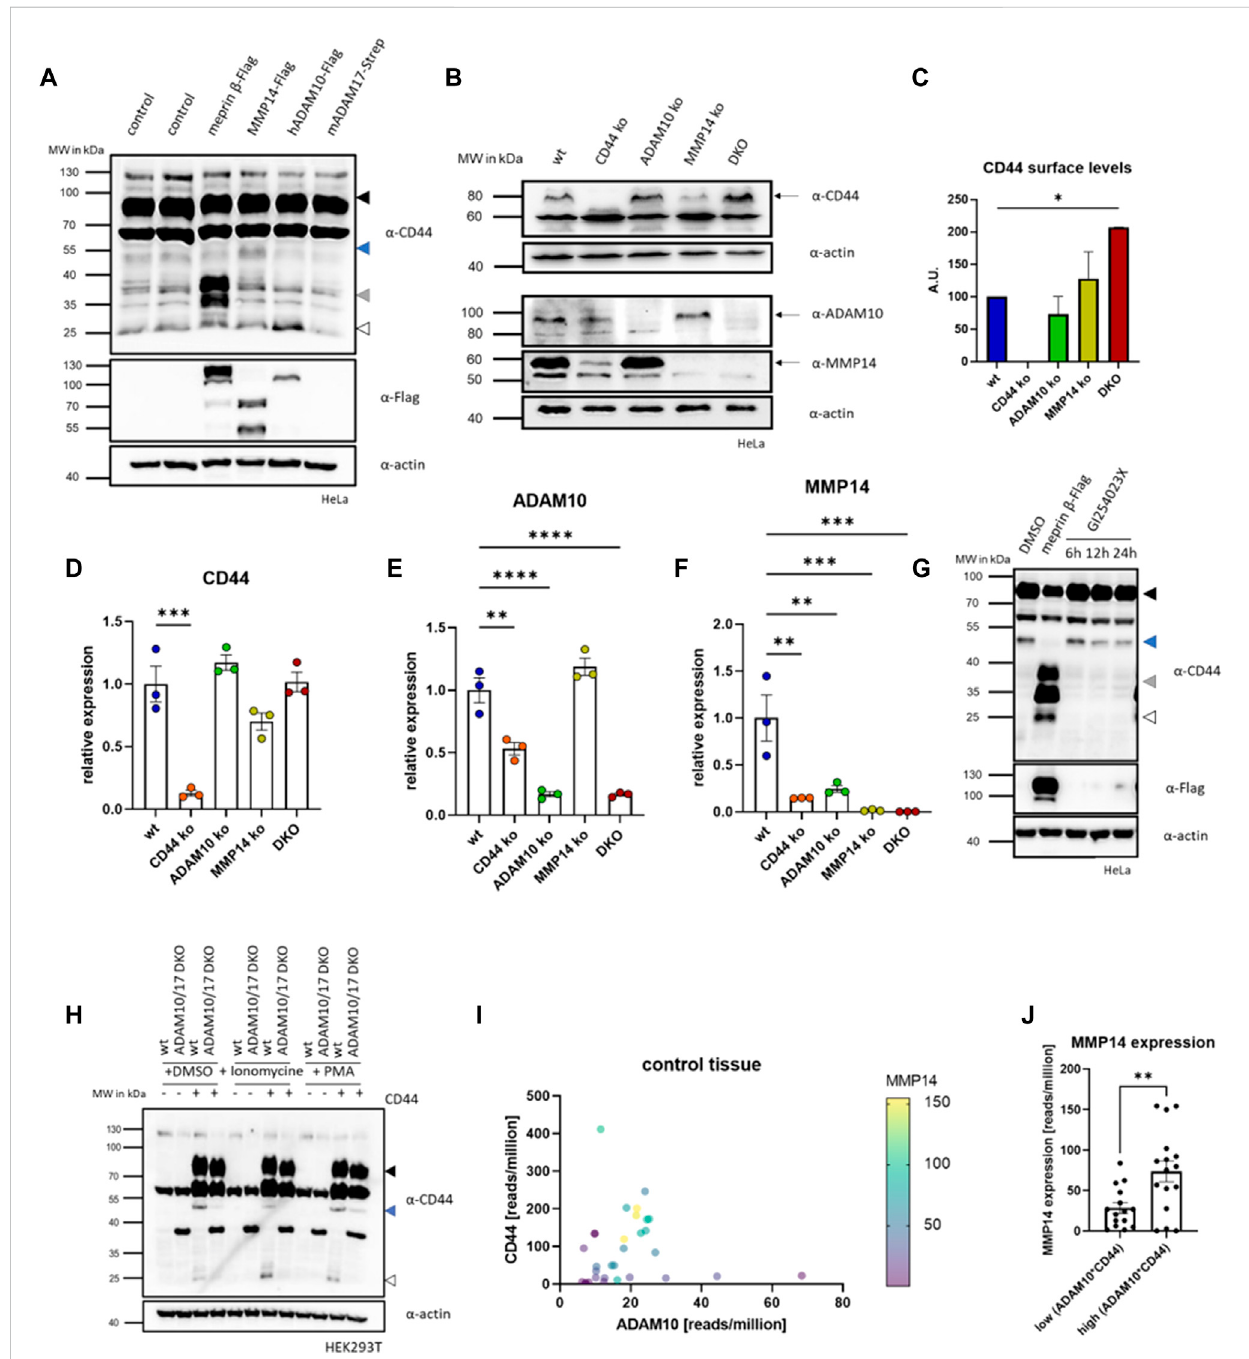
FIGURE 2 CRISPR/Cas9ofCD44andsheddingenzymes. (A) WesternblotofHeLacellsexpressingdifferentCD44cleavingproteases.Arrowsindicatedifferent membrane associated CD44 cleavage fragments (black = full-length CD44, blue = 50 kDa CD44, grey = 37 kDa fragment, white = 25 kDa CTF). (B) Western blot of different CRISPR/Cas9 generated HeLa cell lines de fi cient for CD44 (CD44 ko), ADAM10 (ADAM10 ko), MMMP14 (MMP14 ko) and ADAM10 and MMP14 (DKO). (C) FACS analysis of CD44 cell surface levels (n = 3, values with SEM, one-way ANOVA). (D) Transcriptional level of CD44 determined by qRT-PCR in the different CRISPR/Cas9 generated cell lines (n = 3, values with SEM, one-way ANOVA). (E) Transcriptional level of ADAM10 determined by qRT-PCR in the different CRISPR/Cas9 generated cell lines (n = 3, values with SEM, one-way ANOVA). (F) Transcriptional level of MMP14determinedbyqRT-PCRinthedifferentCRISPR/Cas9generatedcelllines(n=3,valueswithSEM,one-wayANOVA). (G) WesternblotofHeLacell lysates against CD44 in cells expressing meprin β or incubated with the ADAM10 inhibitor GI254023X for different time periods (arrows as in a). (H) Western blot of HEK293T wt and ADAM10 and ADAM17 double de fi cient (DKO ADAM10/17) HEK293T cells against CD44. Cells were transfected with CD44 and additionally cleavage of CD44 was induced by stimulation of endogenous ADAM10 (Ionomycine) or ADAM17 (PMA). (I) Analysis of GTEx (gene tissue expression) data derived from the Gepia2 server. Expression values are plotted against CD44 ( y -axis) and ADAM10 ( x -axis). Expression levels